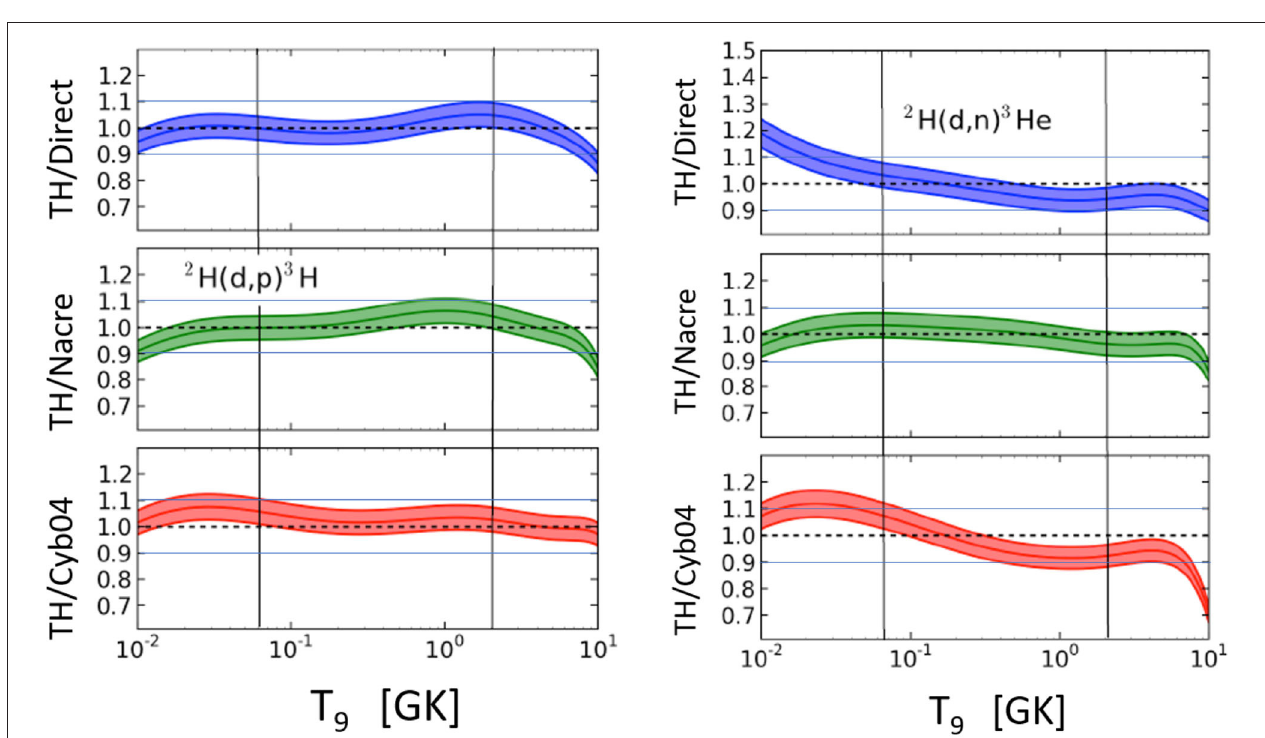
FIGURE 8 | (Left) Trojan Horse 2 H(d,p) 3 H reaction rates as a ratio to the one obtained from direct data fit in the upper panel; the middle and lower panels show rates as a ratio to rates published in NACRE (Angulo et al., 1999; Cyburt, 2004). Lower and upper temperature of interest for BBN are marked by the vertical lines. Blue lines define the ± 10% deviation from the unity. The figure is adapted from Pizzone et al. (2014). (Right) Same reaction rates ratios as in the left figure but for 2 H(d,n) 3 He. The figure is adapted from Pizzone et al. (2014).